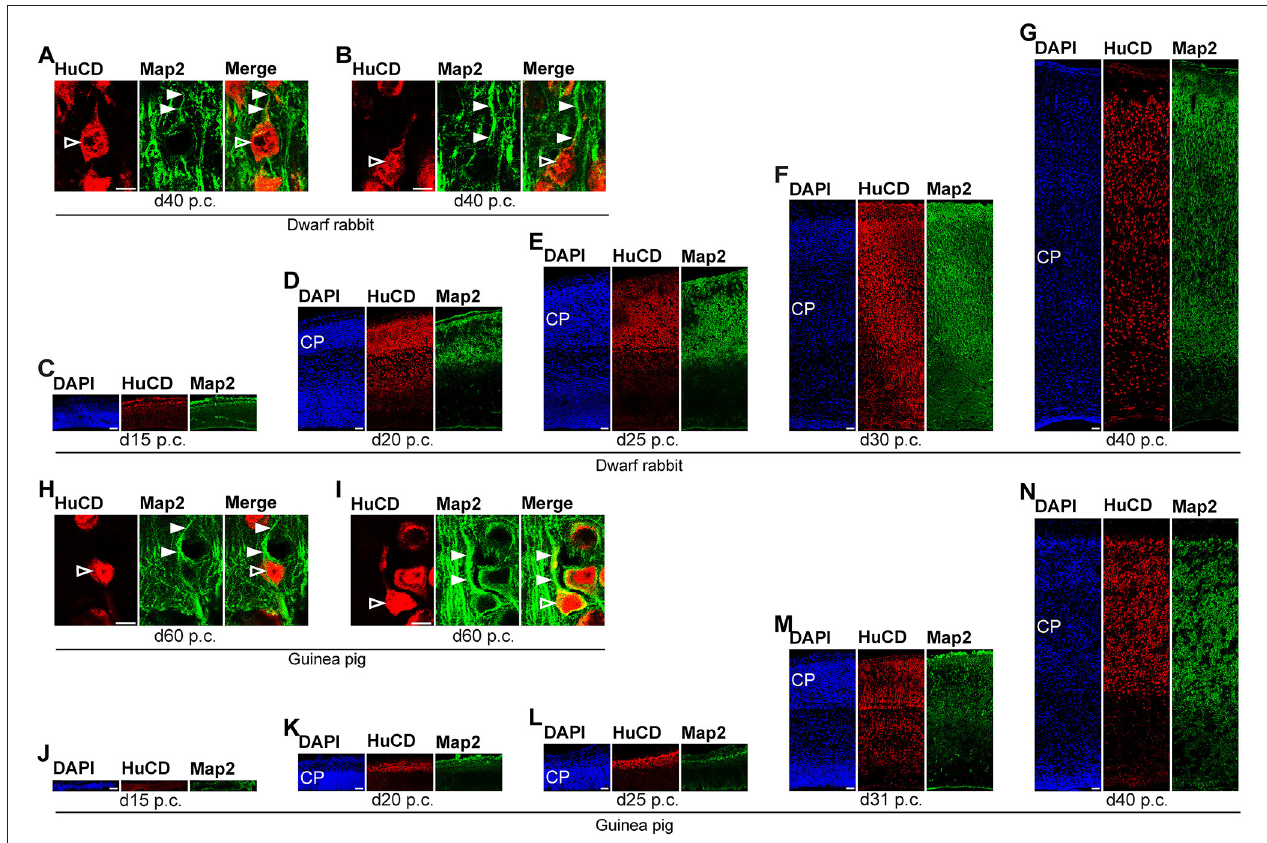
FIGURE 6 | Hu C/D and Map2 expression in the developing dwarf rabbit and guinea pig neocortex. (A–N) Double immunofluorescence for Hu C/D (red, A–N ) and Map2 (green, A–N ) and DAPI staining (blue, C–G,J–N ) on 30- µ m cryosections of day 15 to 40 post-conception (p.c.) dwarf rabbit (A–G) and guinea pig (J–N) neocortex. Images in (A,B,H,I) show neurons with Hu C/D + soma (open arrowhead) and extending Map2 + dendrites (solid arrowhead) in higher magnification of d40 p.c. dwarf rabbit (A,B) neocortex and d60 p.c. guinea pig (H,I) neocortex. Merge images in (A,B,H,I) show combined immunofluorescence of Hu C/D and Map2. CP, cortical plate. Scale bars, 10 µ m (A,B,H,I) or 50 µ m (C–G,J–N)